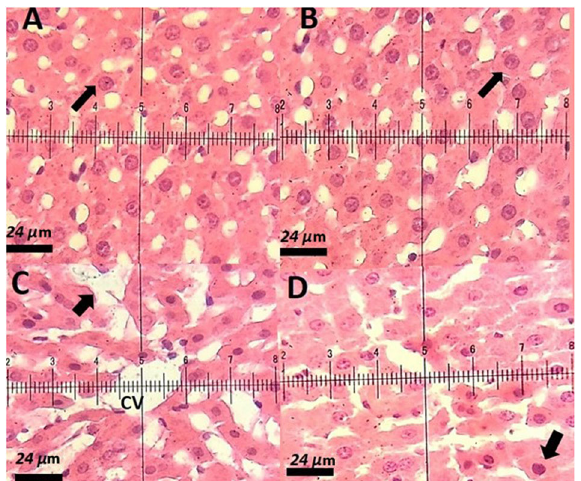
Fig. 9 A Hematoxylin-eosin-stained section of a control rat showing characteristic normal liver histopathology. The arrow indicates a nor- mal hepatocyte with a normal nucleus and cytoplasm. H&E staining (×40); B Liver sections of rat vacuolation (arrow).H&E staining (×40); C Liver section of a PTX-treated rat, a decrease in cytoplasmic vacuolization, arrow point indicates the hepatocytes regeneration. H&E staining (×40); D Liver section of a rat treated with niosomal PTX, a decrease in pyknotic nuclei, H&E staining